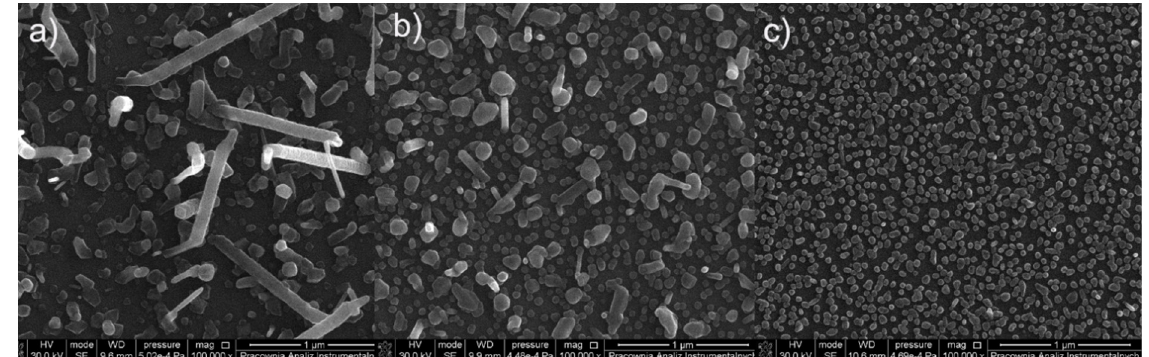
Figure 11. SEM pictures of deposits for the precursor [Cu 2 ( i PrNH 2 ) 2 (µ-O 2 CC 3 F 7 ) 4 ] ( 9 ), Mag = 100,000×, (( a – c )—orderly with the increasing transport way), T V = 473 K, T D = 673 K, Si(111), Ar.